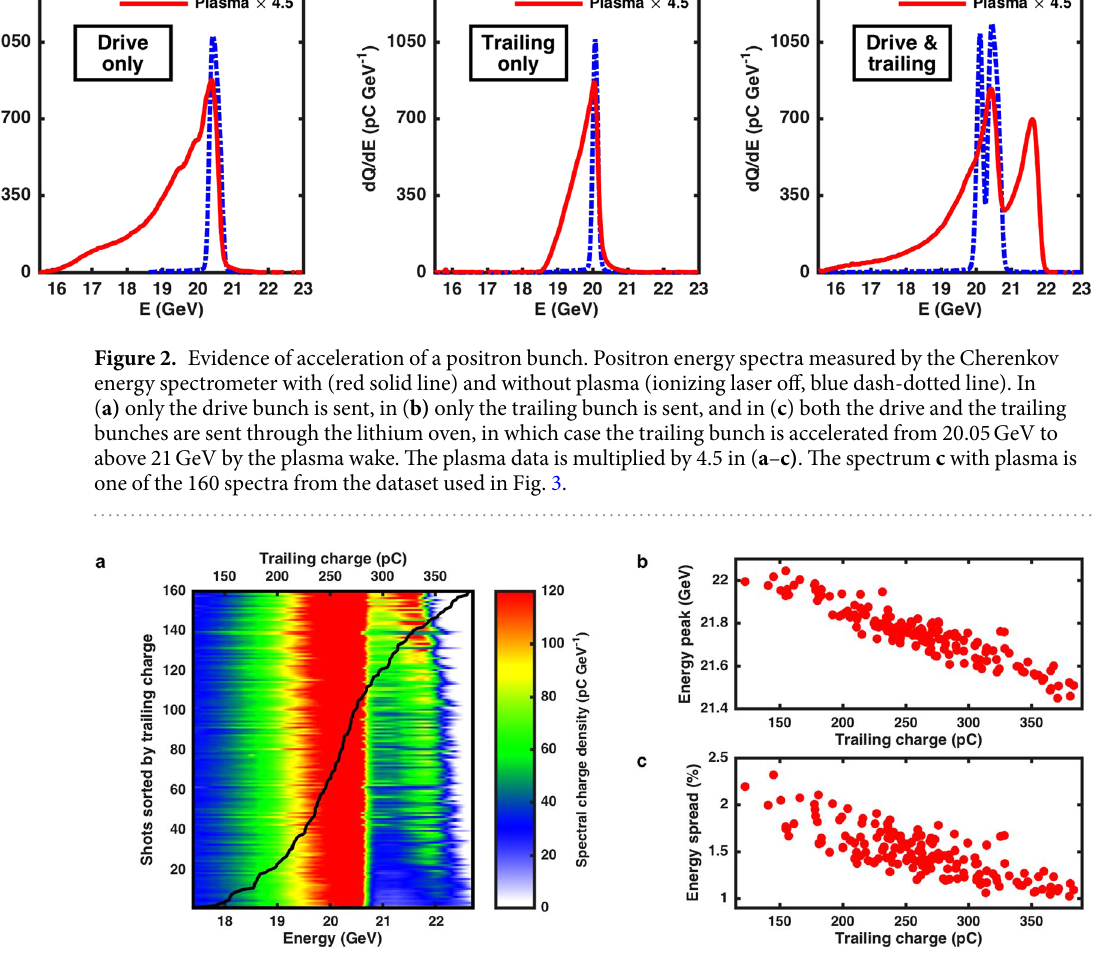
Figure 3. Energy spectra and evidence for the beam-loading phenomenon. ( a) A stack of 160 energy spectra of the positron bunches measured after interaction with the plasma. Each horizontal line represents a single spectrum (see the comments on Fig. 2c). The shots are sorted by increasing trailing bunch charge (black line). The color axis represents the spectral charge density in pC GeV − 1 . ( b ) Energy of the accelerated peak as a function of the trailing bunch charge. ( c) The r.m.s. energy spread of the accelerated peak (obtained from the asymmetric Gaussian fit) as a function of the trailing bunch